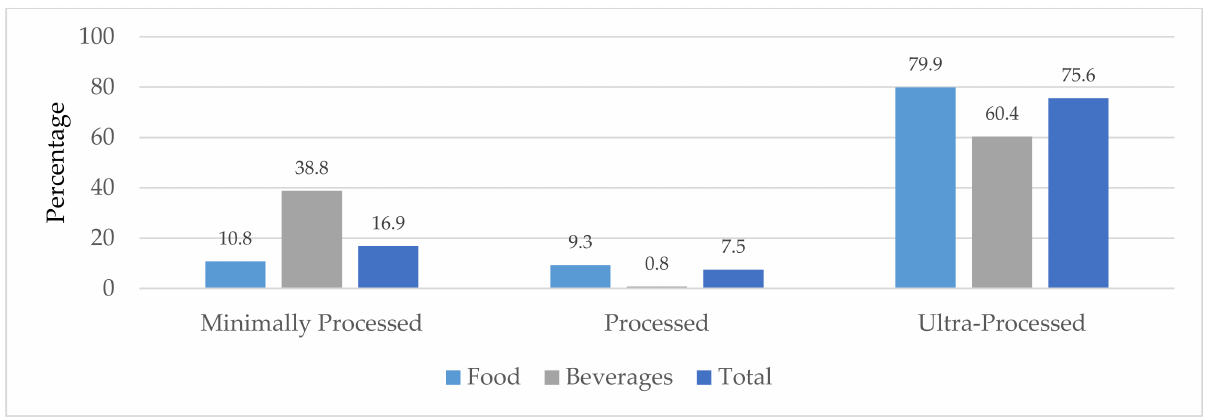
Figure 1. Packaged foods and beverages in the SA marketplace (2018) classified as minimally processed, processed and ultra-processed, according to the NOVA classification system. Note: the NOVA category, ‘culinary ingredients’ has been omitted from